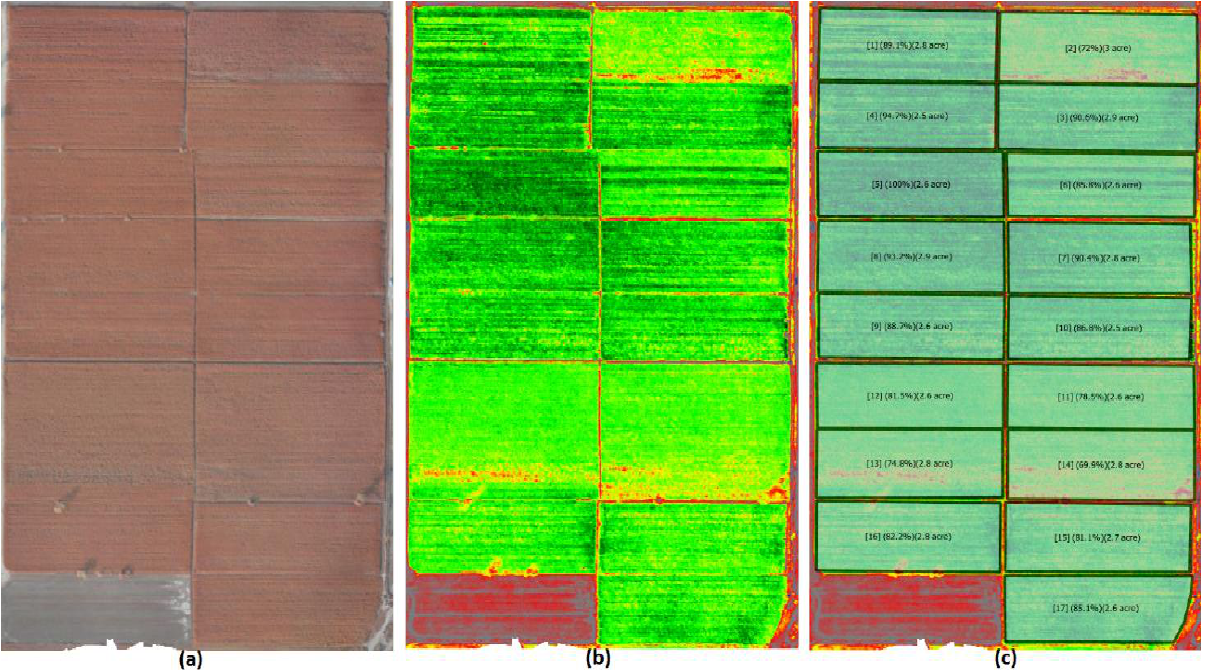
Figure 8. Resultant (a) NGB (b) NDVI Orthomosaic of first